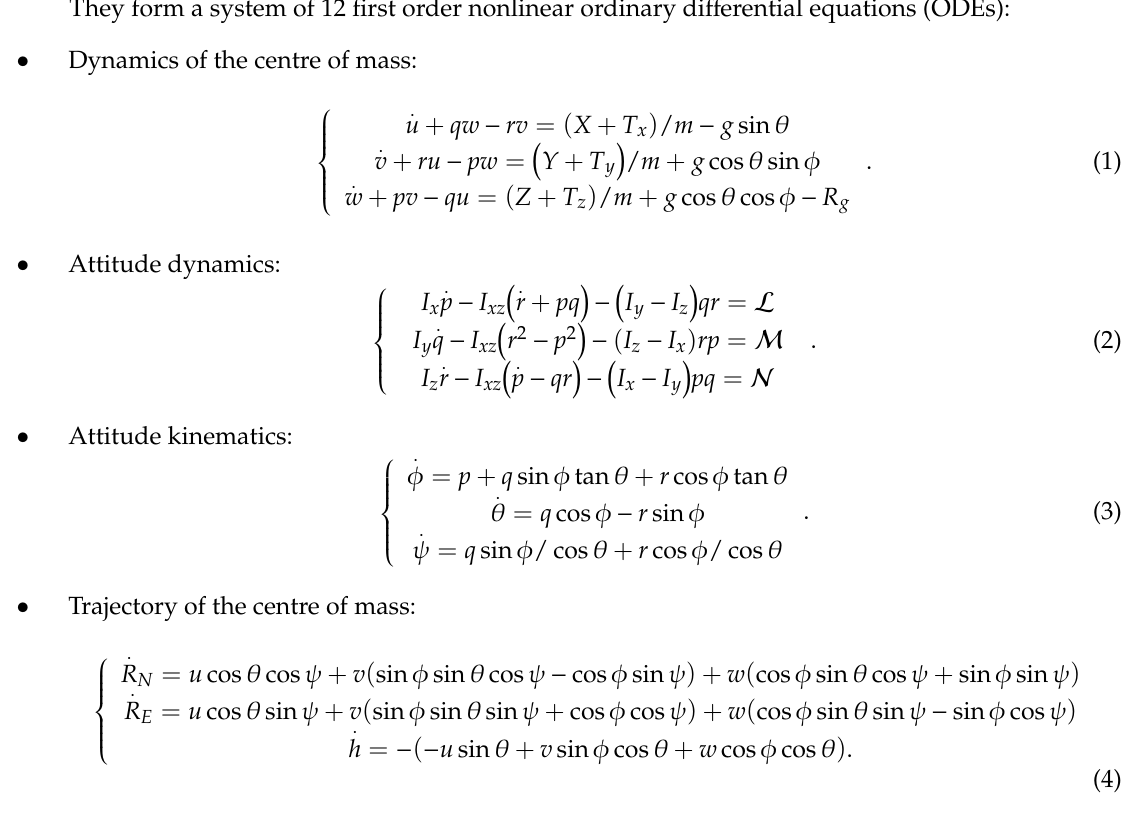
Figure 2. Unmanned aerial vehicle (UAV) body axes ( x B ,y B ,z B ) with: ( u , v , w ) velocities of the UAV centre of mass; ( X , Y , Z ) aerodynamic forces; ( p , q , r ) angular speeds; ( L , M , N ) roll, pitch and yaw aerodynamic moments, ( ϕ , θ , ψ ) roll, pitch and yaw angles; T thrust; R g ground reaction; m mass.